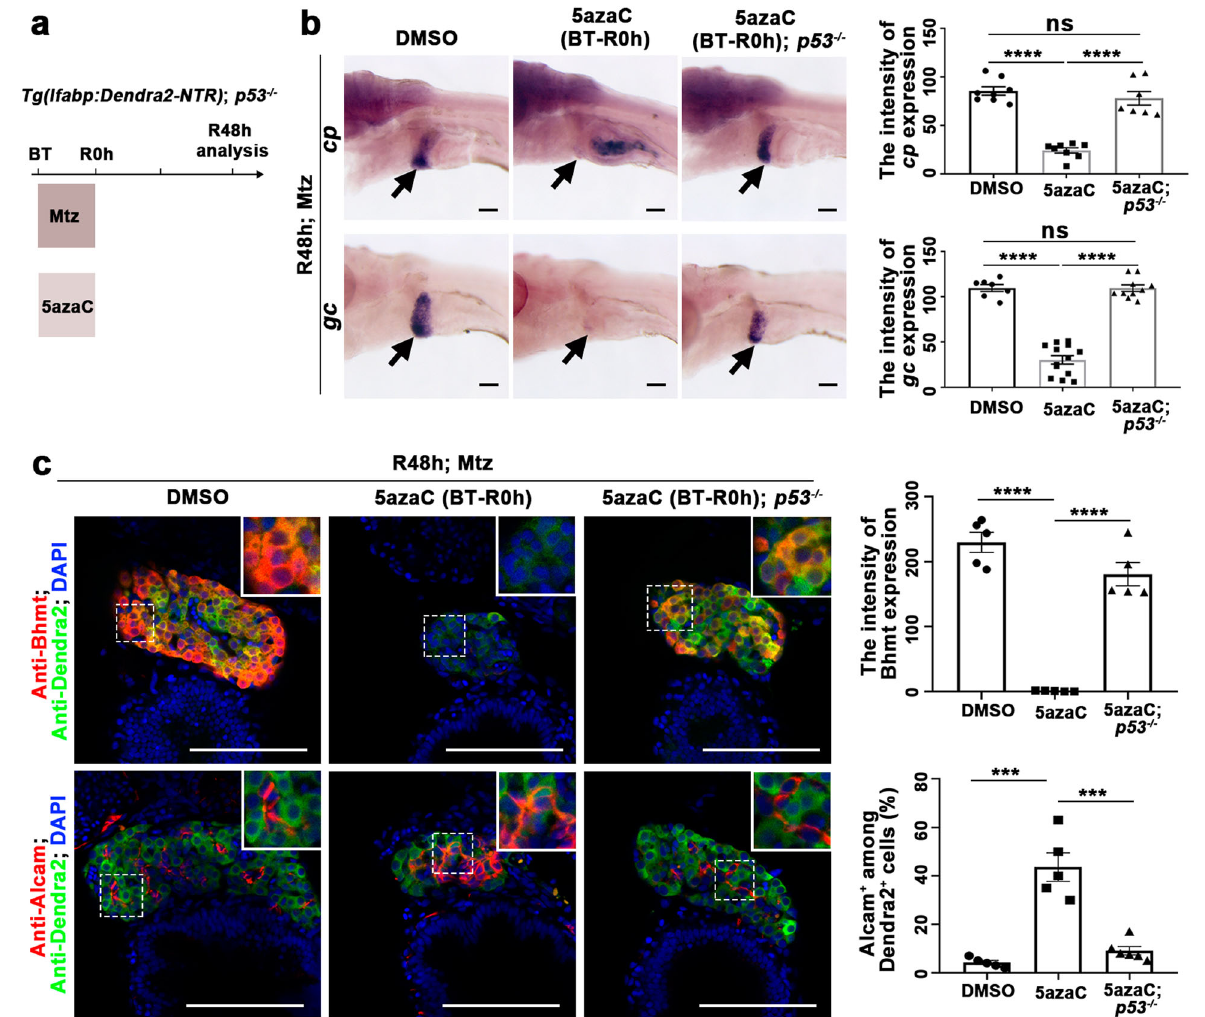
Fig. 4 Loss of p53 rescues liver regeneration defect after early DNA methylation inhibition. a Experimental scheme illustrating the 5azaC and Mtz treatment and analysis at R48h. b WISH images showing the expressions of hepatocyte markers cp and gc at R48h in WT and p53 mutant after early DNA methylation inhibition. Note that the expressions of cp and gc were recovered in p53 mutant after 5azaC treatment. Quanti fi cation of the intensity of cp and gc expression in liver regions at R48h. c Single-optical section images showing the expressions of hepatocyte marker Bhmt and BECs marker Alcam in WT and p53 mutant after early DNA methylation inhibition and controls at R48h. Quanti fi cation of the intensity of Bhmt expression and the percentage of Alcam + among Dendra2 + cells in liver regions at R48h. Note that the expression of Bhmt was recovered in p53 mutant compared to WT after 5azaC treatment. Asterisks indicate statistical signi fi cance: *** P < 0.001; **** P < 0.0001 using t -tests analysis when compared to control. Scale bars: 100 µm; error bars, ±SEM. DAPI 4 ′ , 6-diamidino-2- phenylindole, BT before treatment, ns no signi fi cant difference, R regeneration time after the withdrawal of